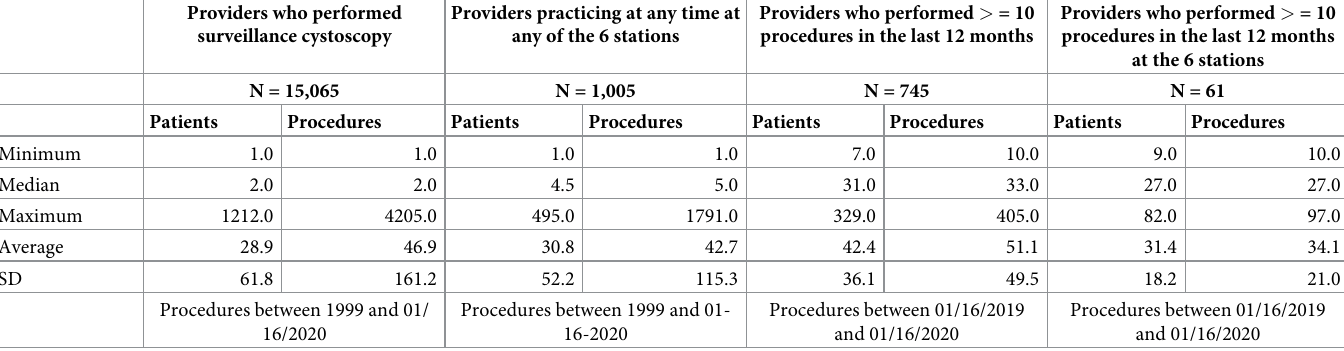
Table 1. Detailing the minimum, median and maximum number of procedures and unique patients for selected provider groups with averages and SD, including the specific procedure timeline. Providers who performed surveillance